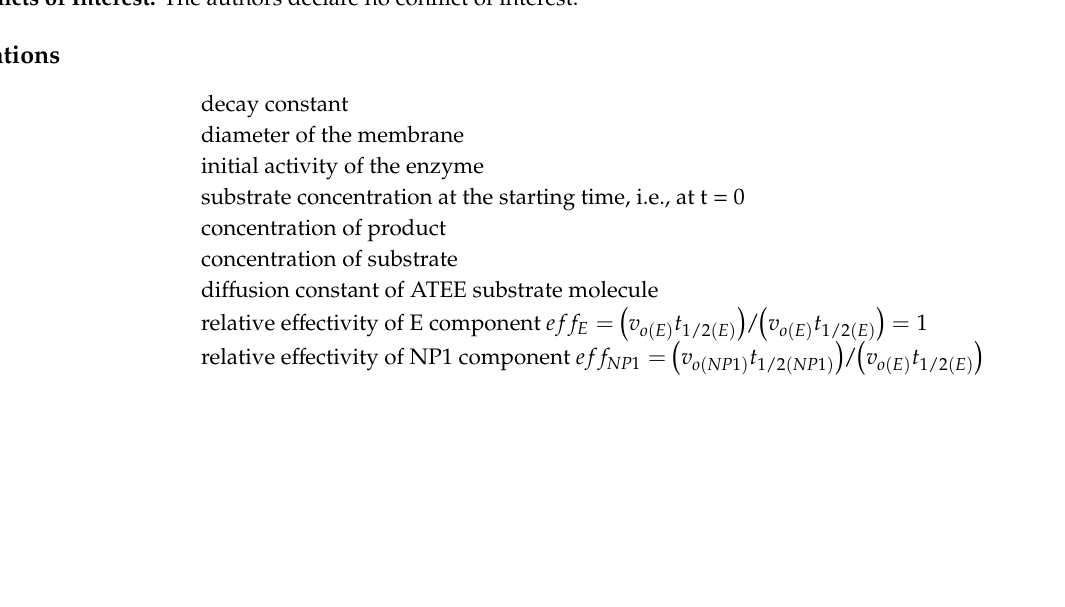
Figure S1: Scanning electron microscopic image of pores of polysulfone / polyamide membrane (support layer) used for enzyme immobilization; Figure S2: Schematic figure of the home-made membrane device, whose temperature and pressure of the feed solution was regulated; Figure S3: Photo of home-made membrane